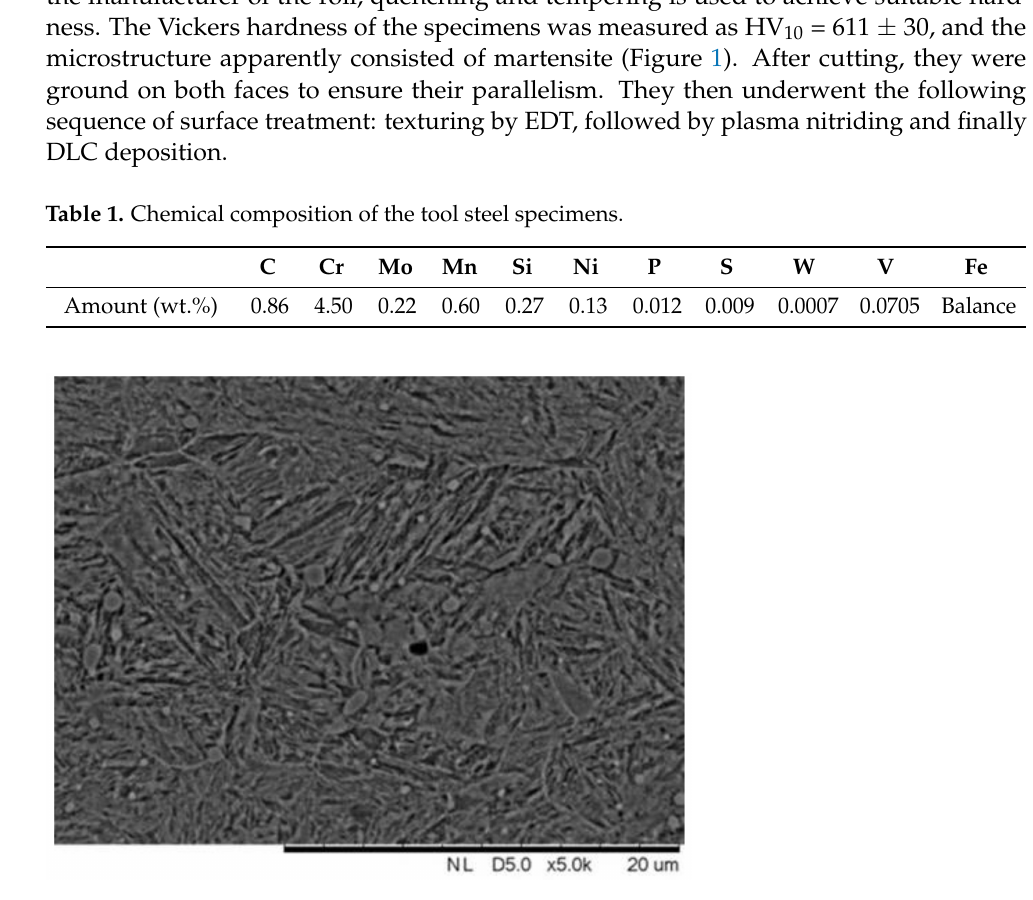
Figure 1. Scanning electron microscopy (SEM) of the specimens before the surface